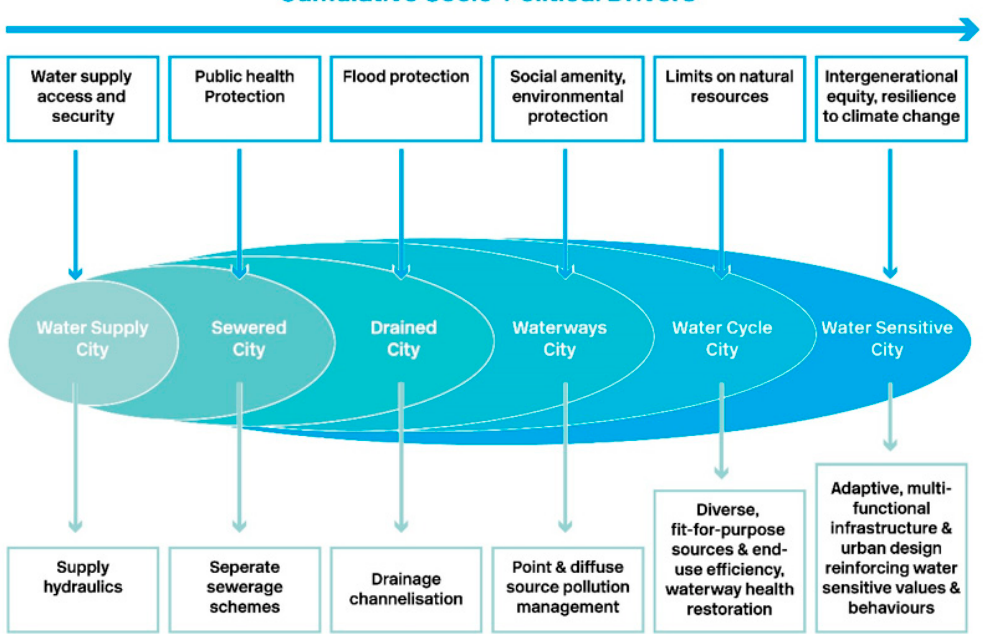
Figure 1. Urban Water Management Transitions Framework [4].